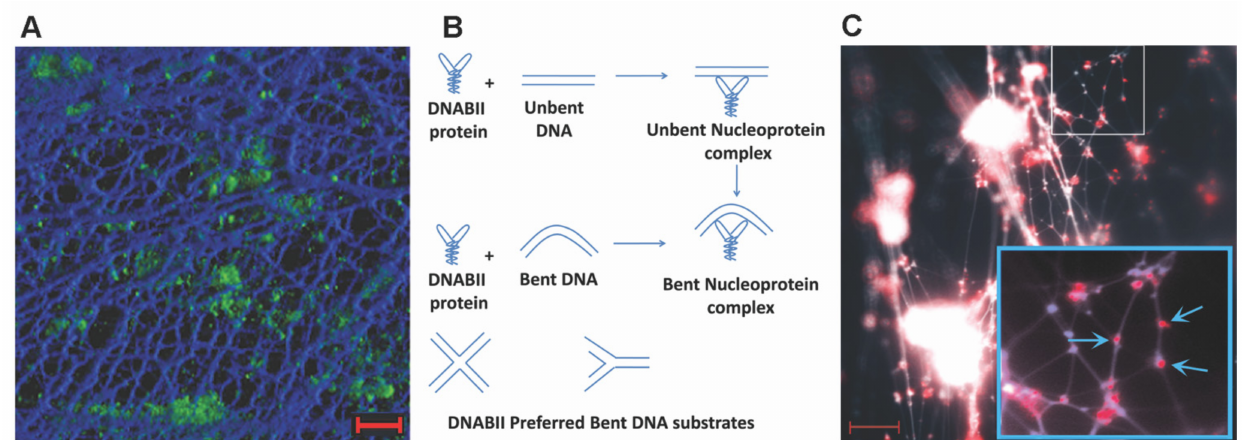
Figure 1. Localization of a DNABII protein at vertices of bent eDNA within an in situ biofilm. ( A ) Immunofluorescent image of a biofilm formed in the middle ear of the chinchilla (21 days after challenge with non-typeable Haemophilus influenzae ). Fine, widely spaced dsDNA strands are labeled with DAPI and appear blue in this image, whereas non-typeable H. influenzae are labeled with FITC- conjugated antiserum directed at a surface-exposed protein and appear green. Marker bar = 5 µ m. ( B ) DNABII family members have a stronger preference for binding to bent DNA—a generalized scheme. ( C ) Immunohistochemical labeling of IHF within an NTHI biofilm formed in vivo. The strong labeling of each vertex where individual strands of DNA cross (arrows) must be noted. FITC, fluorescein isothiocyanate; IHF, integration host factor; NTHI, non-typeable Haemophilus influenzae . Reprinted from Ref.